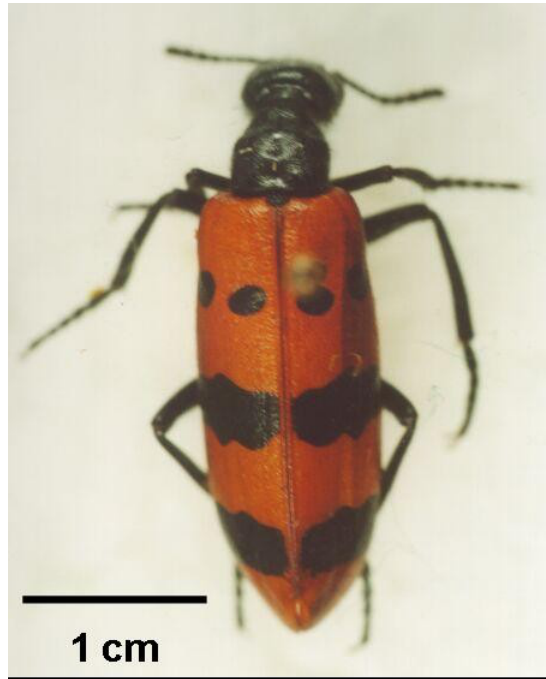
Figure 11. Mylabris impressa (Coleoptera: Meloidae), the predominant species in the western province of Hamedan.